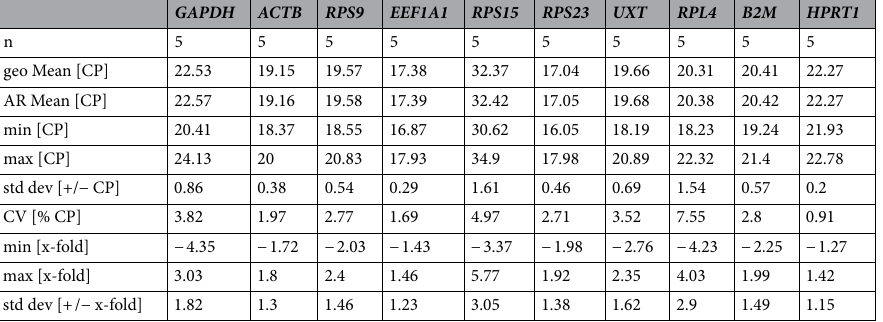
Table 12. Analysis of parameters based quantitative cycling points (CP) for 10 candidate RGs in